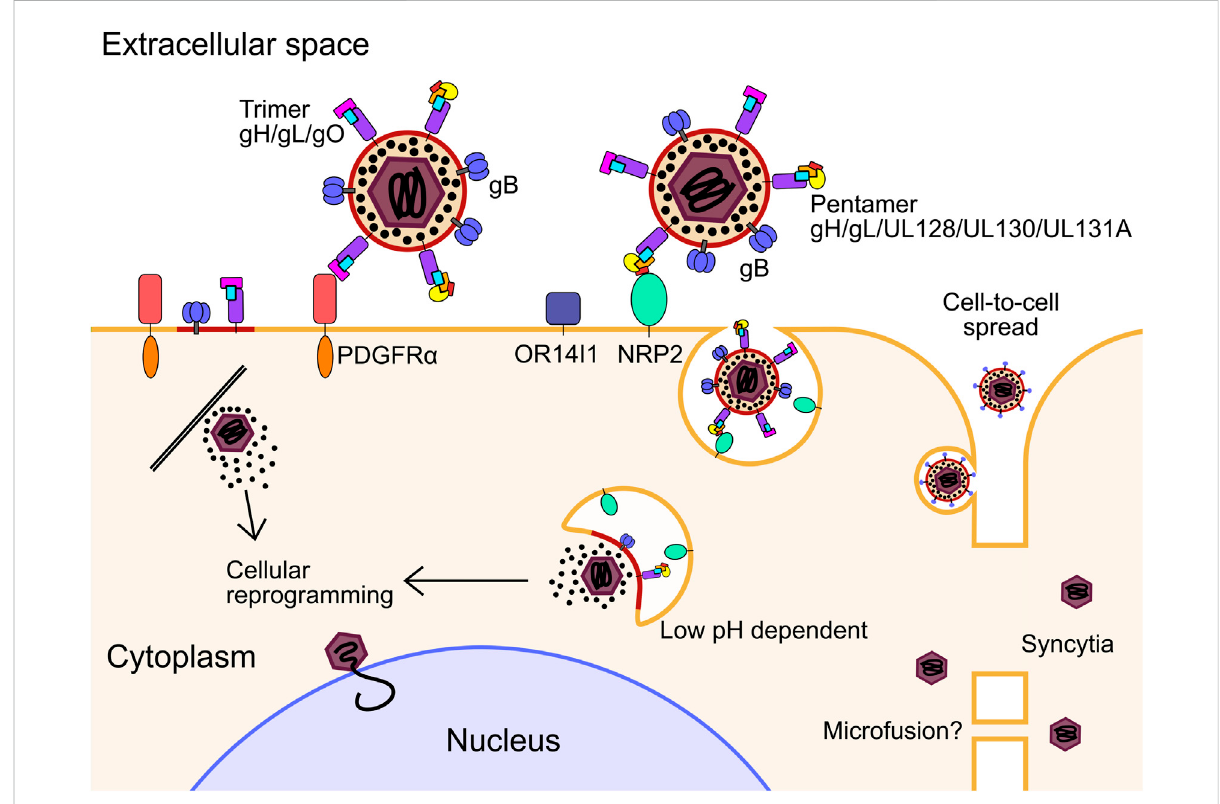
FIGURE 1 For infection in fi broblasts, the glycoprotein trimer consisting of gH, gL and gO binds to PDGFR α . Fusion between the envelope and cell membrane is mediated by gB and the tegumented nucleocapsid is released into the cytoplasm. For infection of epithelial, endothelial, myeloid, and likely many other cell types, the glycoprotein pentamer consisting of gH, gL, UL128, UL130 and UL131A binds to either OR14I1 or NRP2 on the cell surfaceandinducesendocytosisofthevirion.Pentamermediatedentryisdependentonacidi fi cationoftheendosomeaswellasgO.Thefusion step ismediatedby gBto release thetegumented capsidintothecytoplasm,and tegument proteins dissociateand beginto reprogram thehost cell. The capsid traf fi cs to the nucleus for genome deposition. PDGFR α , platelet derived growth factor receptor alpha; NRP2, neuropilin; gB, envelope glycoprotein